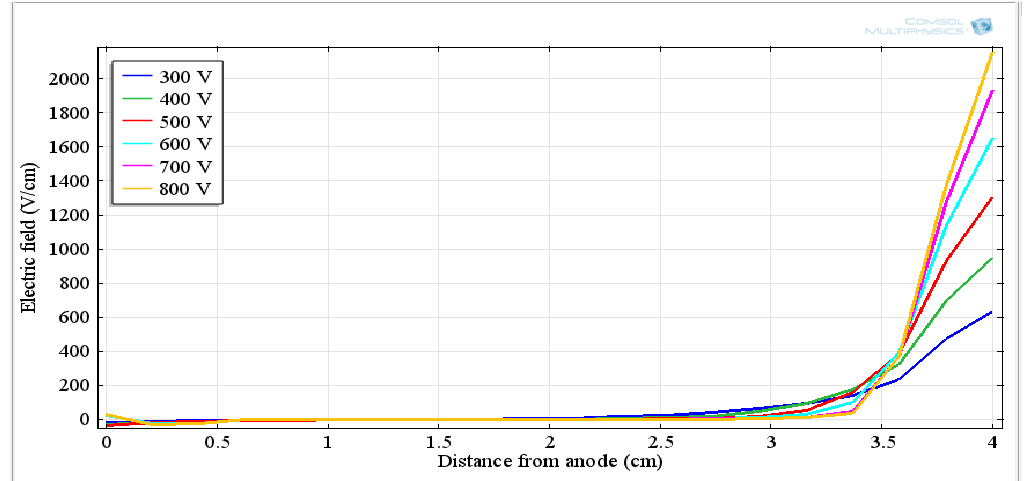
Fig. 4: Electric field profile distribution along the axial distance from